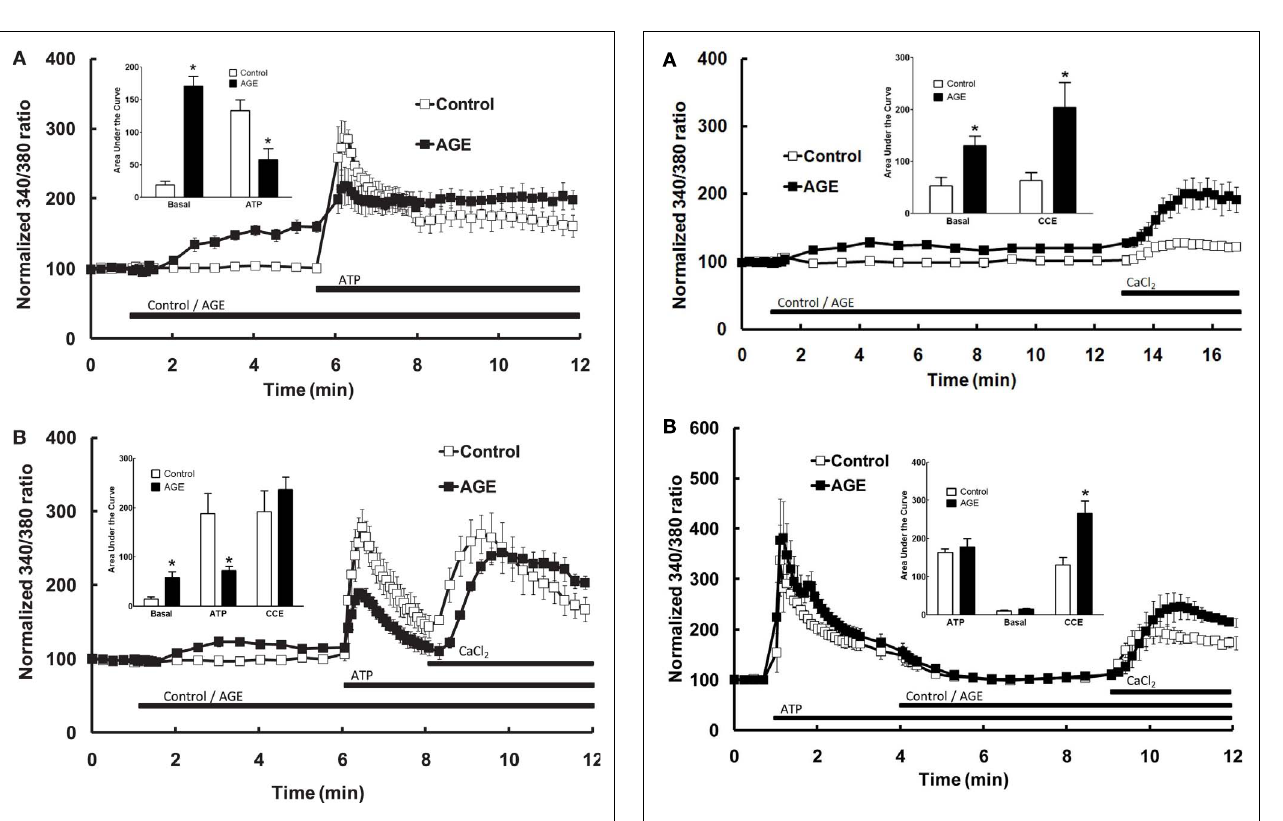
FIGURE 3 | Effect ofAGEs onATP-induced Ca 2 + signaling in BAEC. (A) In the presence of extracellular Ca 2 + , AGEs alone induced an increase in [Ca 2 + ] and inhibited the subsequent ATP-induced Ca 2 + increase, as shown in the inset (Area Under Curve data). (B) In the absence of extracellular Ca 2 + , AGEs alone induced an increase in [Ca 2 + ], inhibited ATP-induced intracellular Ca 2 + release but did not affect CCE upon the re-addition of extracellular Ca 2 + (CaCl 2 ). Points and columns represent the mean ± SEM of five to six recordings. *Indicates significant effect of AGEs compared to control ( P < 0.05, t -test).